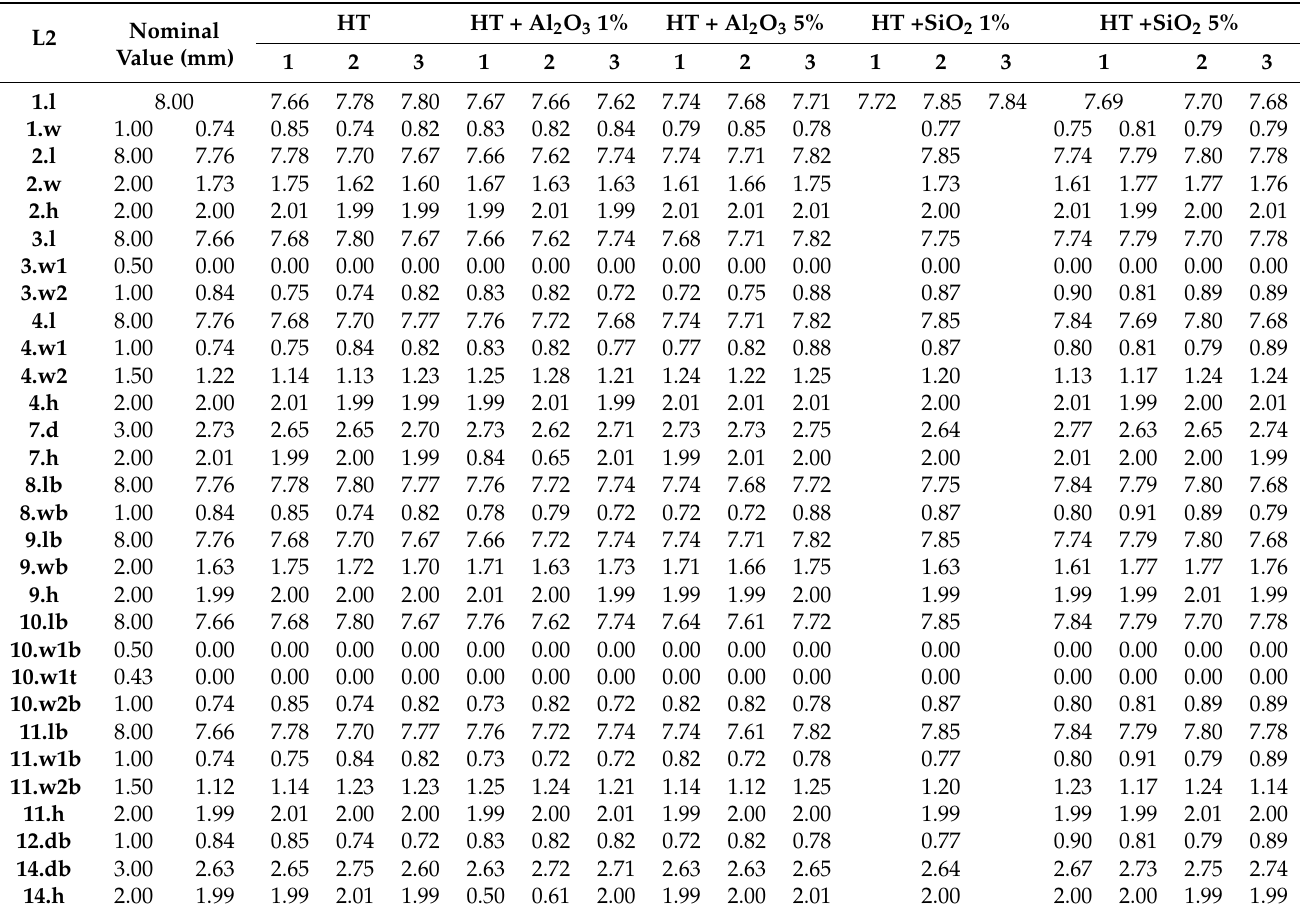
Table A2. Dimensional analysis detailed measurement results (inward